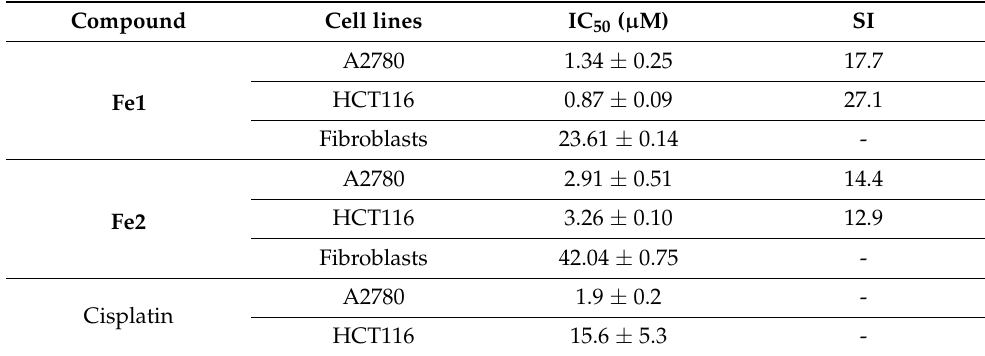
Table 1. Relative IC 50 of complexes Fe1 and Fe2 and of cisplatin on the A2780, HCT116, and fibroblasts cell lines. The selectivity index (SI) of the complexes is also presented. Data expressed as mean ±